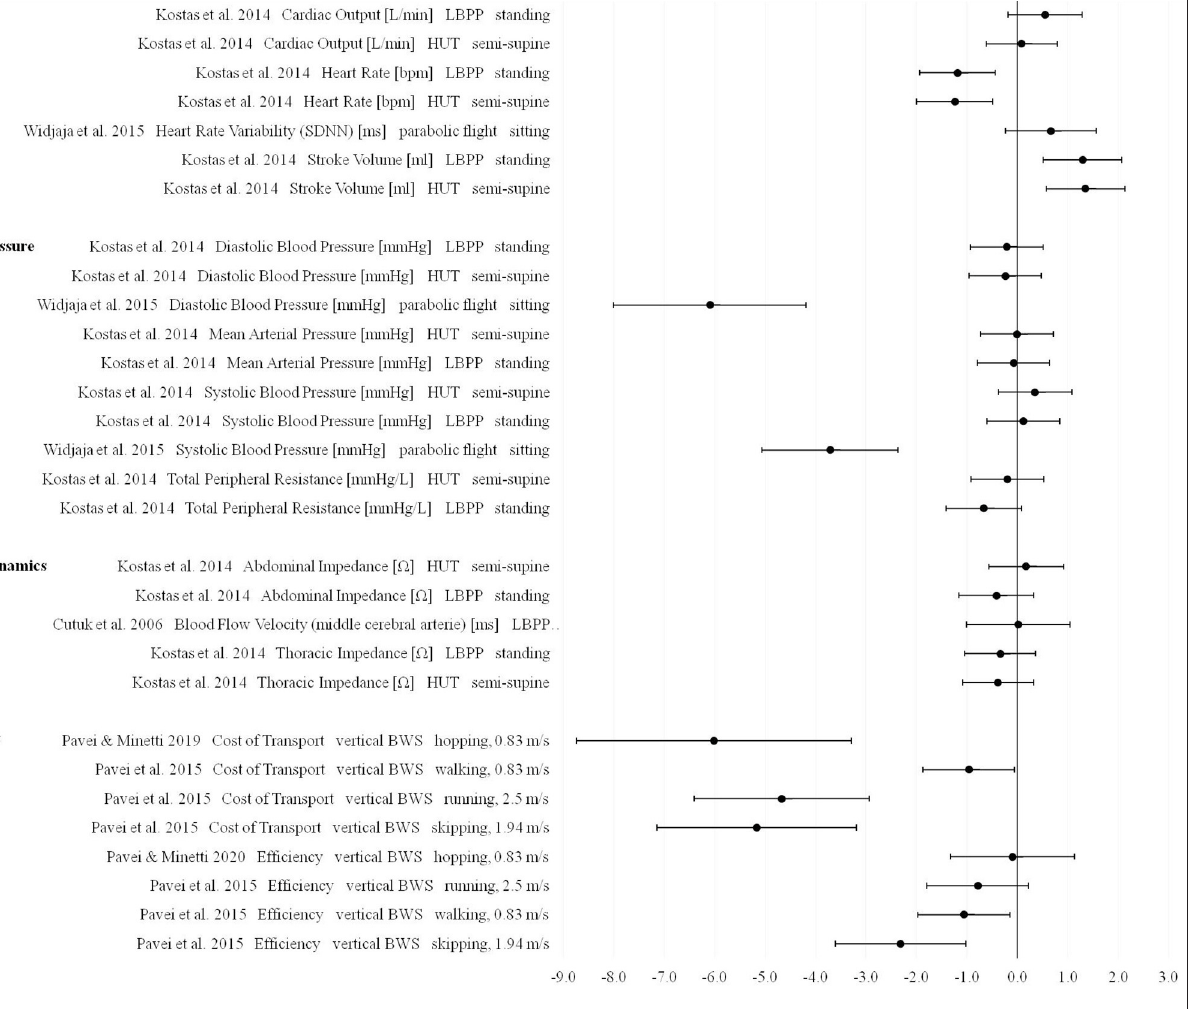
FIGURE 6 | Effect sizes (Hedge’s g) and confidence intervals for cardiopulmonary parameters in Martian gravity compared to